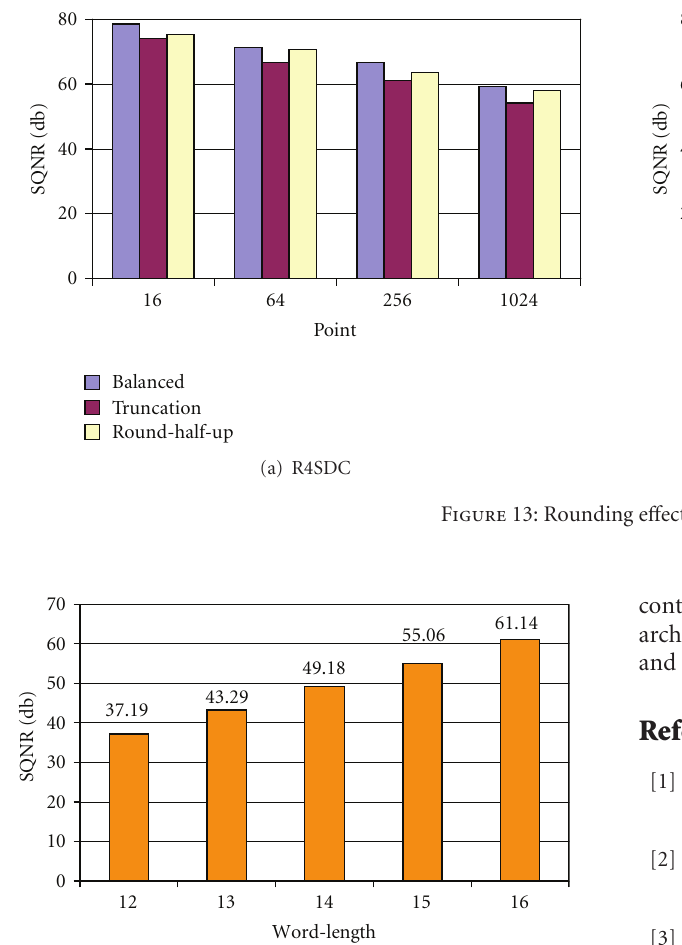
Figure 14: SQNR variation with di ff erent word lengths.